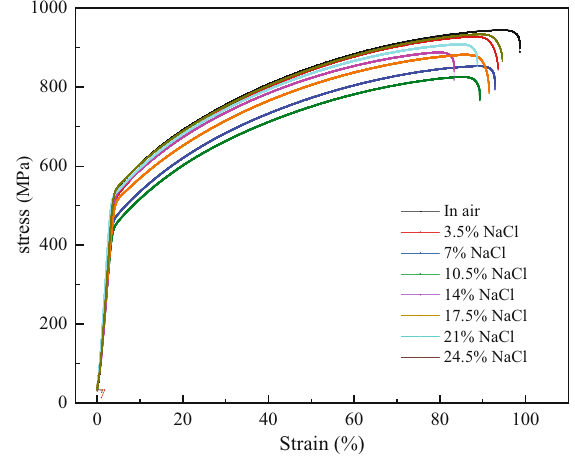
Figure 4: SSRT stress – strain curves of samples in air and di ff erent Cl − concentrations.